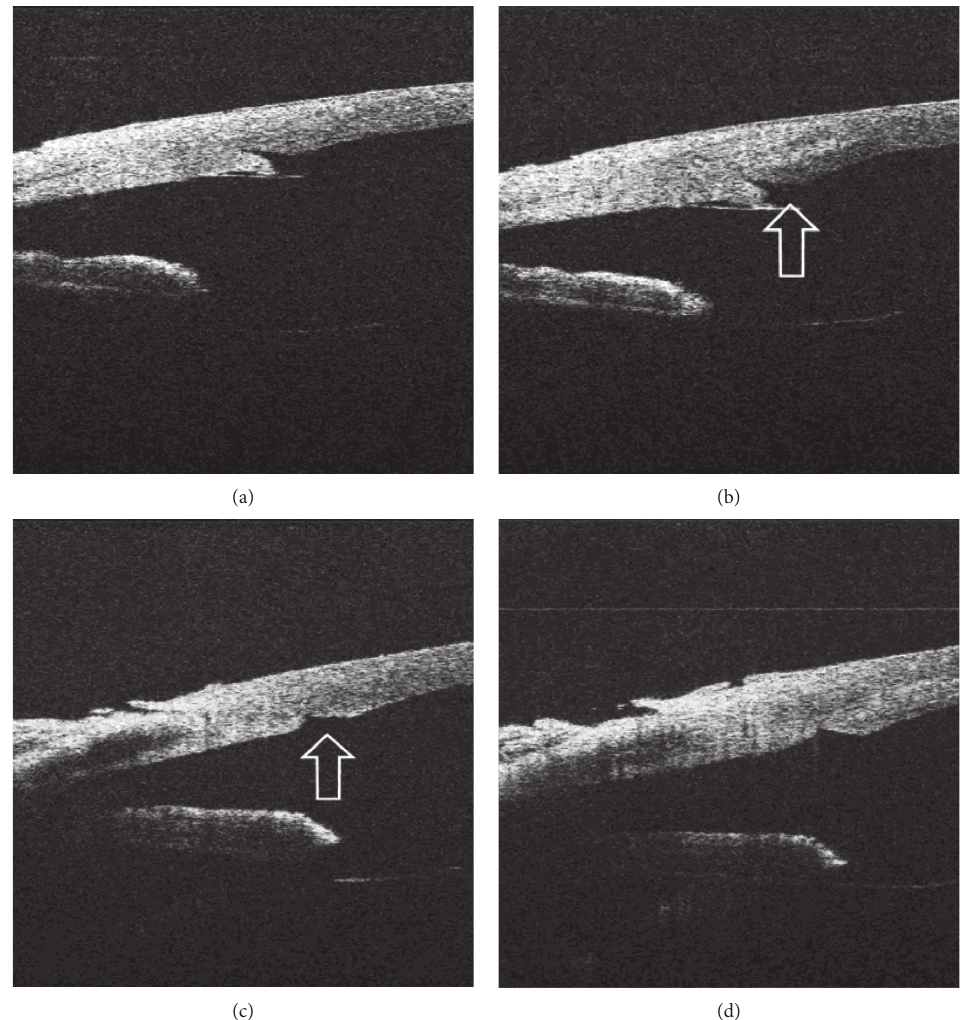
Figure 3: Prominence of posterior lip of the corneal incision before (a) and after (b) hydration, tongue inversion into the incision before (c) and after (d) hydration. In both cases, lateral stromal hydration had no significant effect on corneal incision architecture. The arrow shows the exposed central part of the incision ceiling; this may explain the gap of the incision orifice visible with a operating microscope (see Figure 3(b) corresponds with 5(a), respectively, and 3(c) with